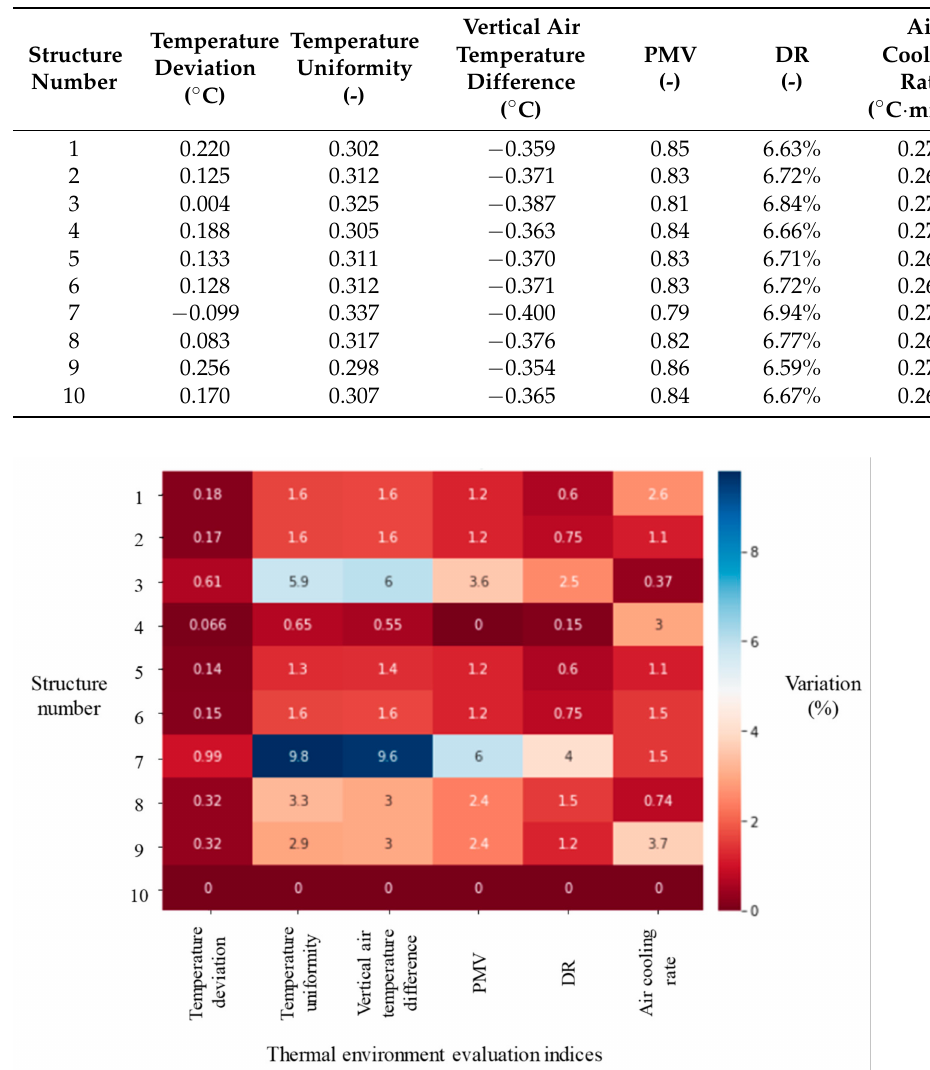
Figure 9. Color map of the evaporator structure effects on the thermal